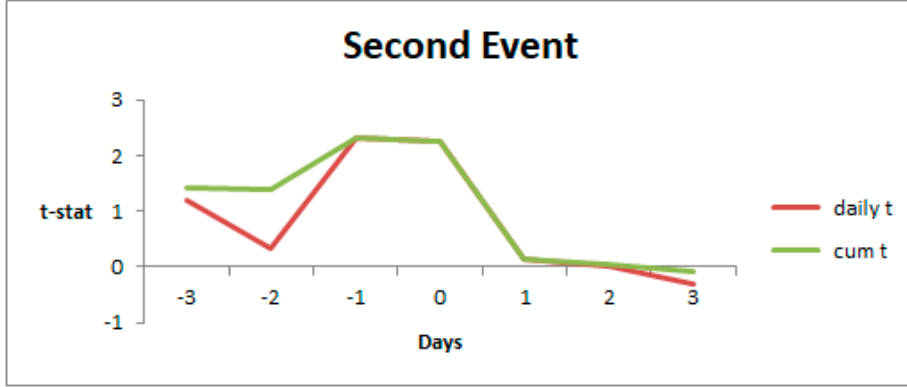
Figure 2. Daily t for AAR and cumulative t for CAAR. Source: Authors’ work.